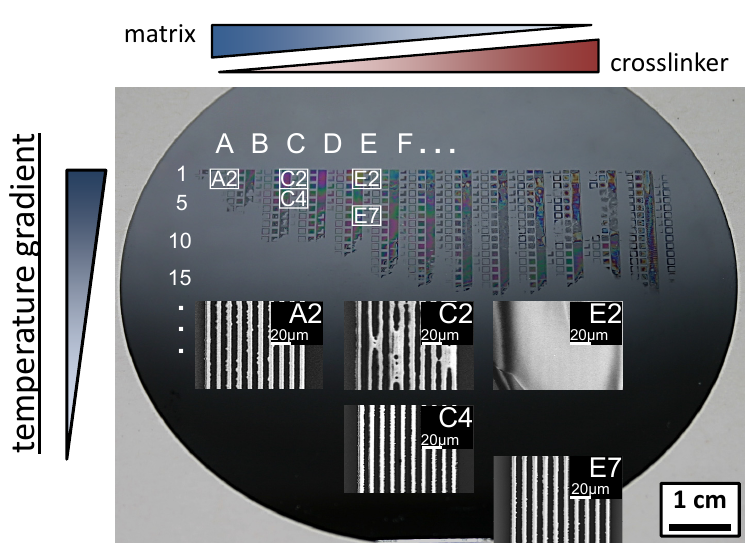
Figure 8. Photograph of the patterned resist film on the silicon wafer after applying the material composition gradient (left to right: column A to N ), post apply bake of 115 °C for 60 s, photo exposure (60 mJ/cm²), PEB temperature gradient (top to bottom: row 1 to 40 ) and development in a 0.26 N aqueous solution of tetramethylammonium hydroxide for 10 s. Already with the naked eye can be seen that below row 15 (60 °C) all patterns are completely stripped off. The dependence of temperature to material composition is obvious by the SEM insets of column E : sector E7 shows distinct pattern while in sector E2 all lines are merged. Under the conditions of a steady temperature (row 2 ) distinct pattern are obvious at high matrix content (sector A2 ) while with increasing crosslinker content the patterns tend to merge ( C2 / E2 ). A trend is observable as for higher crosslinker content lower PEB temperatures are needed for distinct patterns ( A2 , C4 , E7